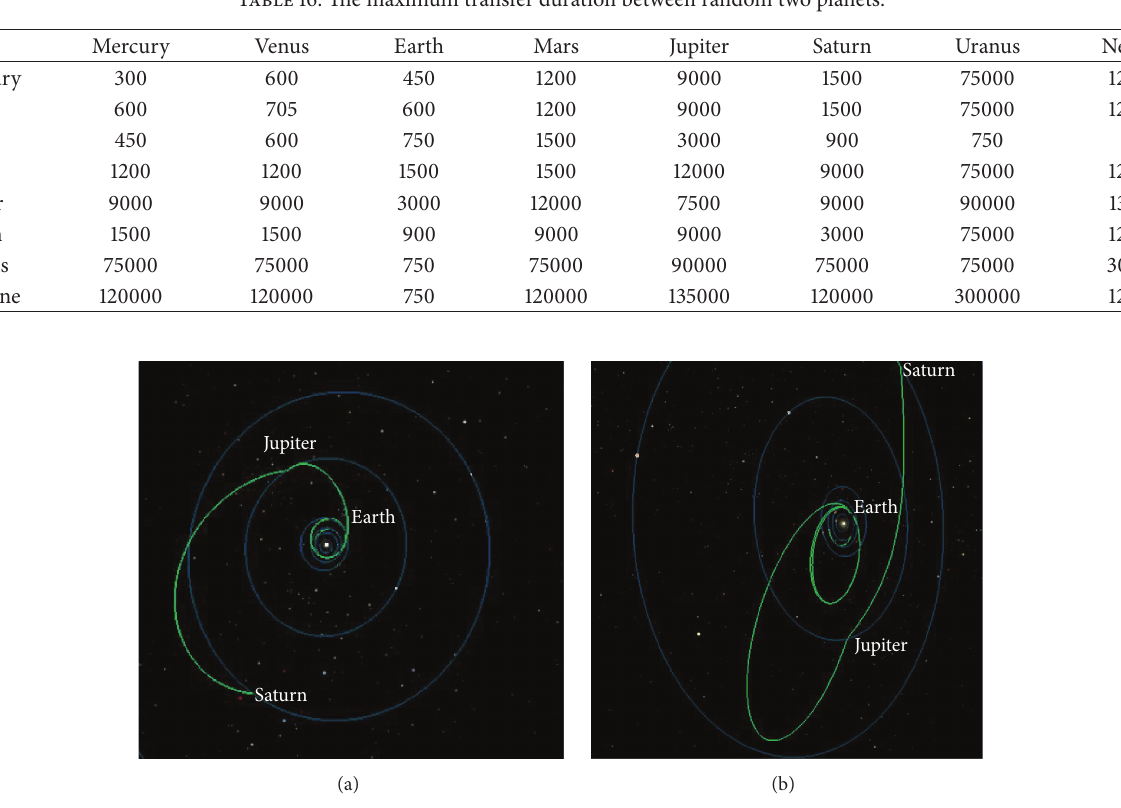
Figure 10: Trajectories simulation of Cassini (a) and GTOC1